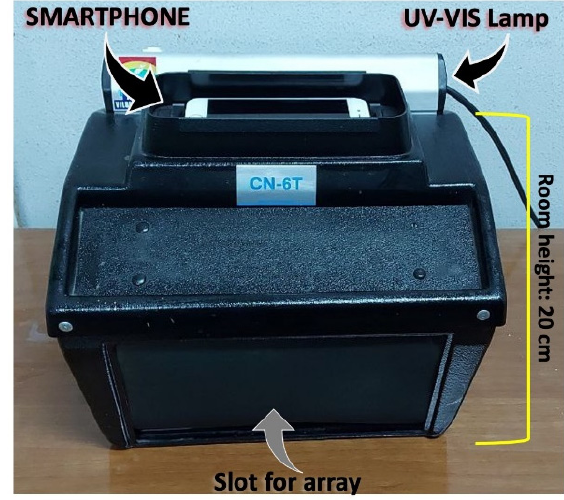
Figure 6. Dark chamber used in this work.